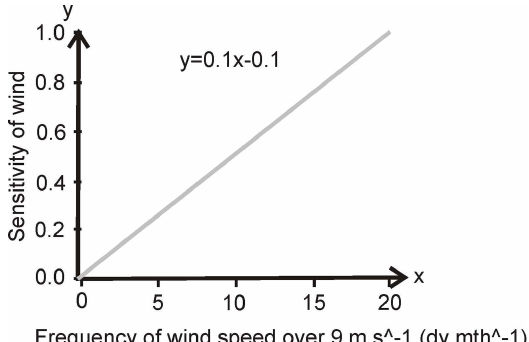
Figure 7. The applied exponential fuzzy membership function of the relation between soil texture (soil erodibility index based on the modelling results of the NAM (2002) and Klik (2004)) and the sen- sitivity to wind erosion.